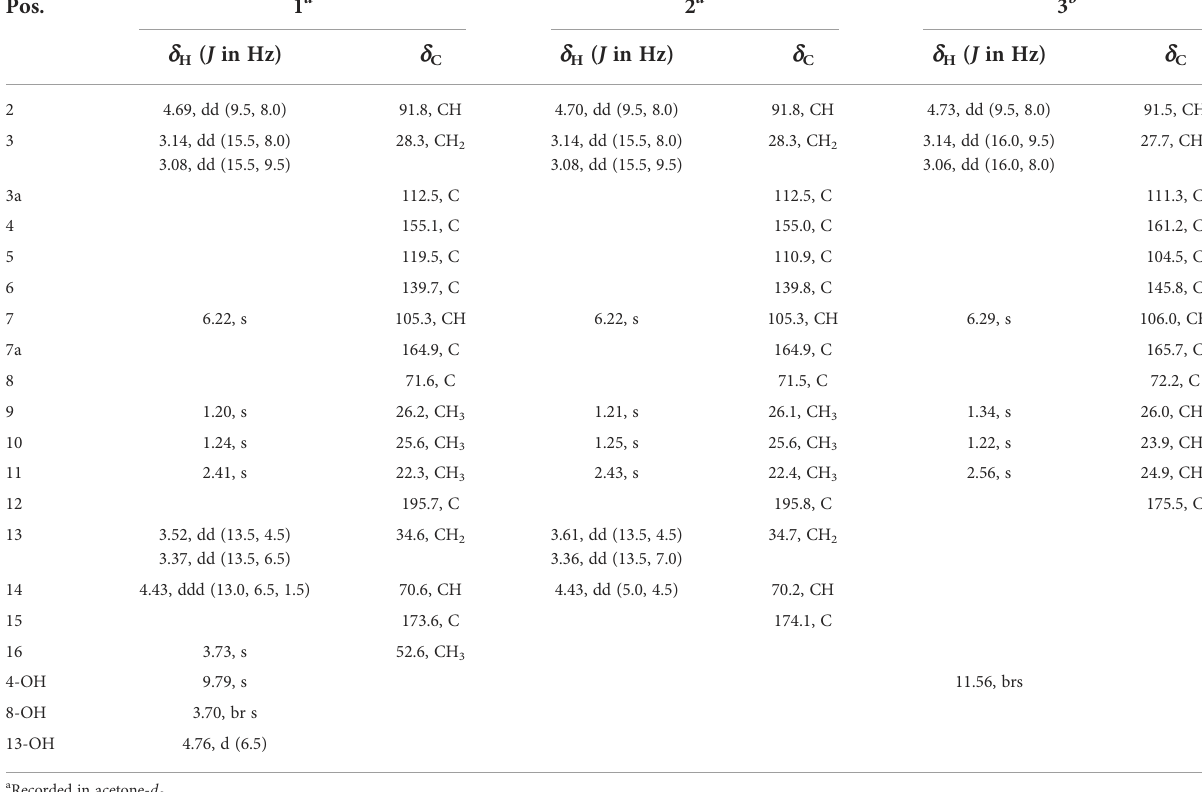
TABLE 1 NMR data for compounds 1 − 3 ( d in ppm, J in Hz).